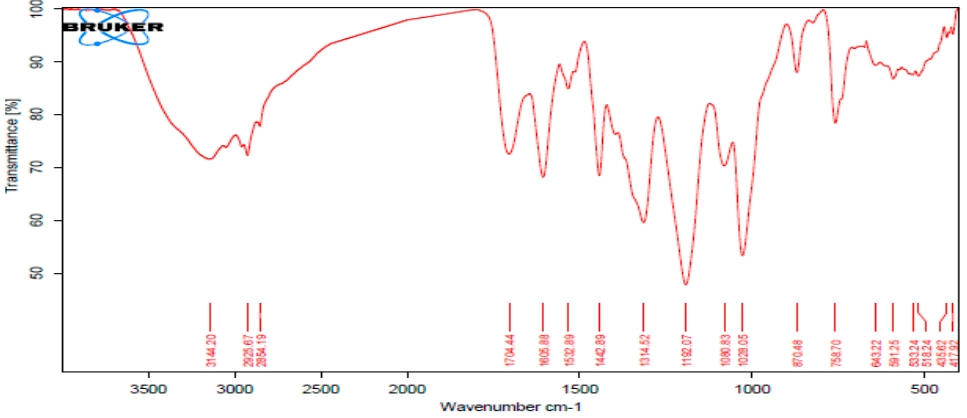
Figure 5. Fourier transform infrared (FT-IR) spectroscopy for P. zonale leaf extract.